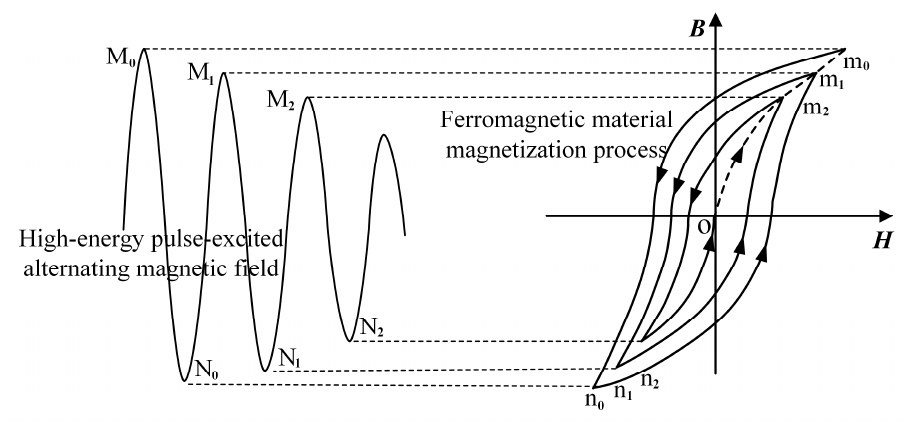
Figure 1. Magnetization process of high-energy pulse excitation.